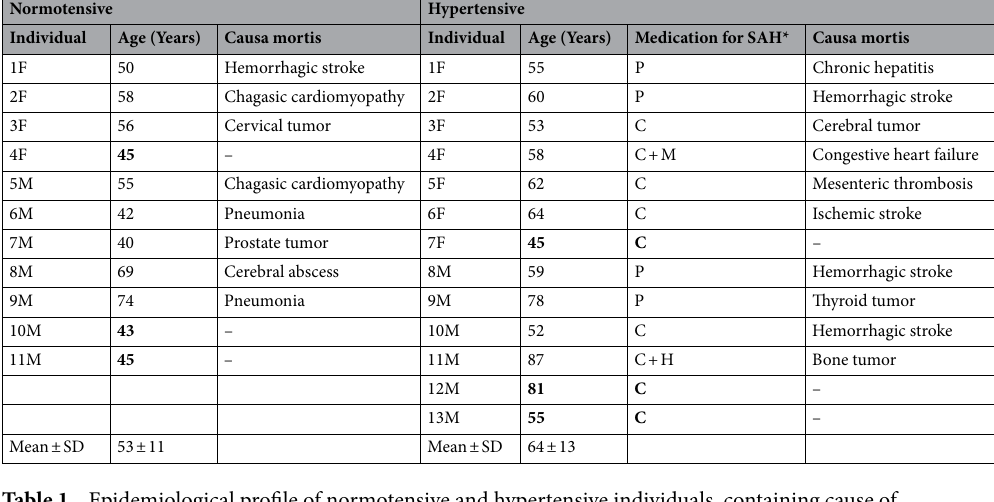
Table 1. Epidemiological profile of normotensive and hypertensive individuals, containing cause of death. M = Male, F = Female; Bold pairs = Different values (p < 0.05); (*) Captopril (C), Propranolol (P), Hidrochlorothiazide (H), Metropolol